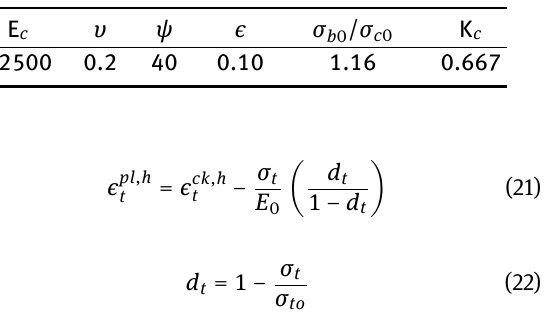
Table 12: Concrete parameters in ABAQUS